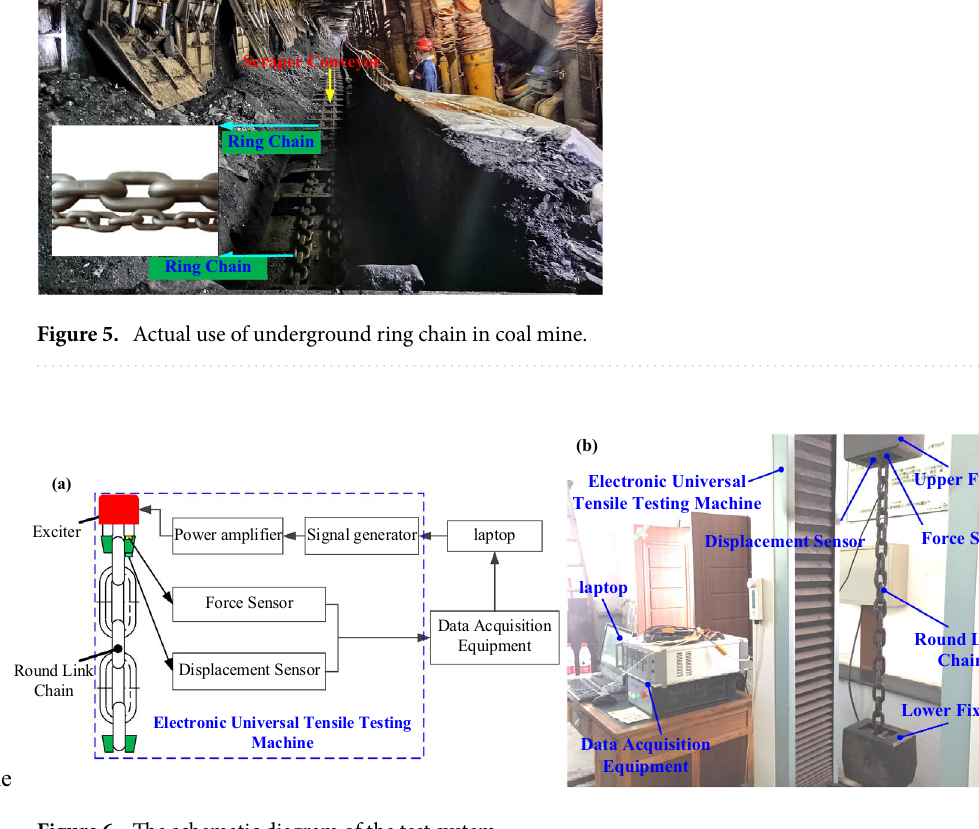
Figure 6. The schematic diagram of the test